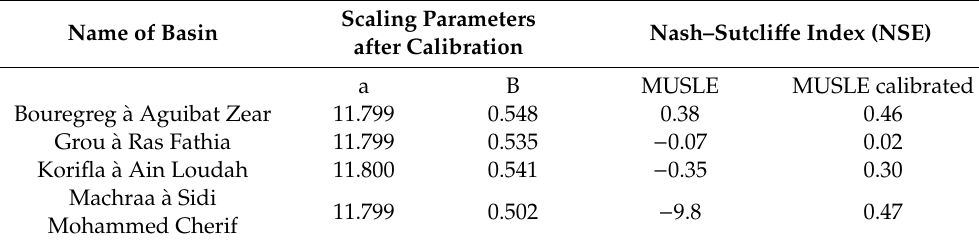
Table 18. Nash–Sutcli ff e index (NSE) at study stations.